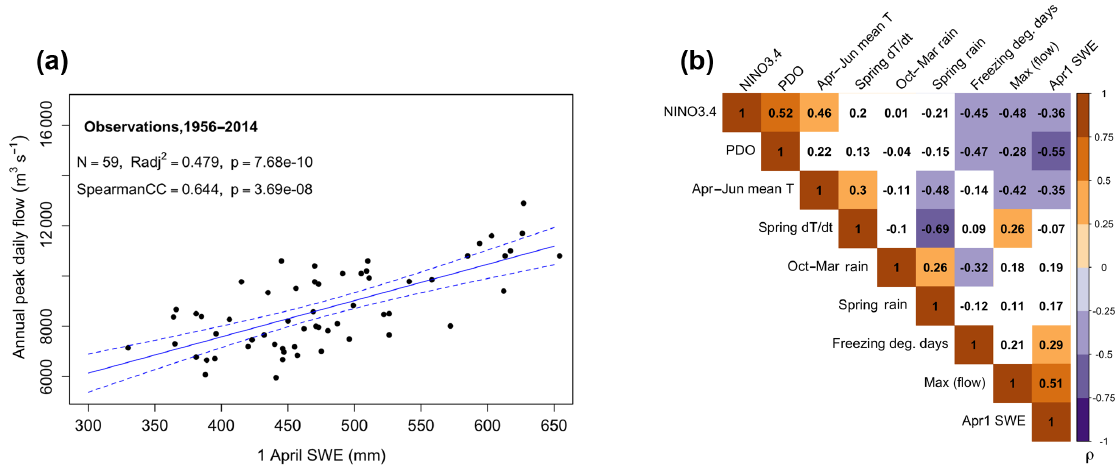
Figure 3. (a) Regression of observed APF against basin-averaged 1 April SWE over the Fraser Basin, within the period of overlapping records, 1956–2014. The solid blue line is the least-squares linear regression fit, while the dashed curves show the 95% confidence interval. Adjusted Pearson and Spearman rank correlation coefficients, along with their associated p -values, are indicated at upper left. (b) Correlo- gram of all observed variables, averaged over the Fraser Basin over the common period of records for all variables, 1956–2006. Numerical values are Spearman rank correlation coefficients, and coloured squares indicate significant correlations at the p < 0.1